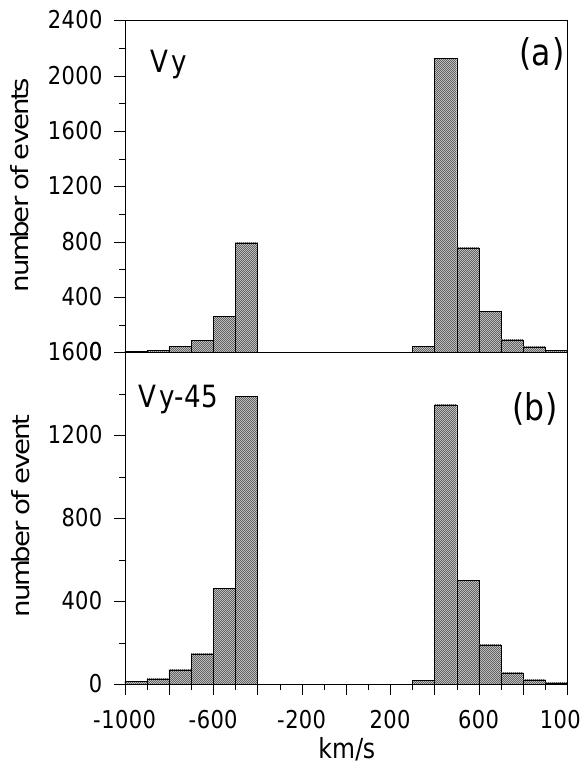
Figure 3 Histogram of the large cross-tail velocity Fig. 3. Histogram of the large cross-tail velocity component occur- component occurrence : a) the original Vy distribution rence: (a) the original Vy distribution (for | Vy | > 400km/s), (b) the (for |Vy|>400 km/s), b) the drift-shifted distribution of drift-shifted distribution of | Vy − 45km/s | . |Vy-45km/s| .